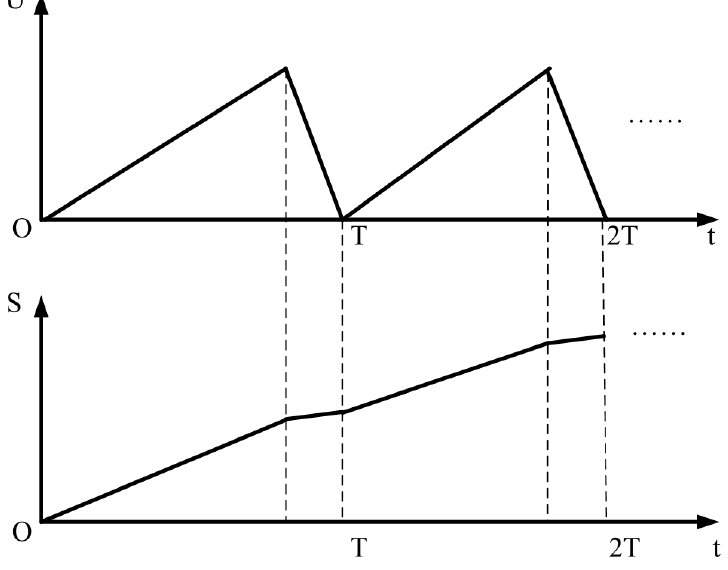
Figure 3. The relationship between the linear displacement increment of the shaft and the applied voltage (T is the cycle of the applied triangular wave voltage).